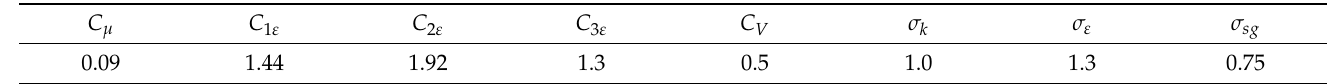
Table 1. Constants in turbulence